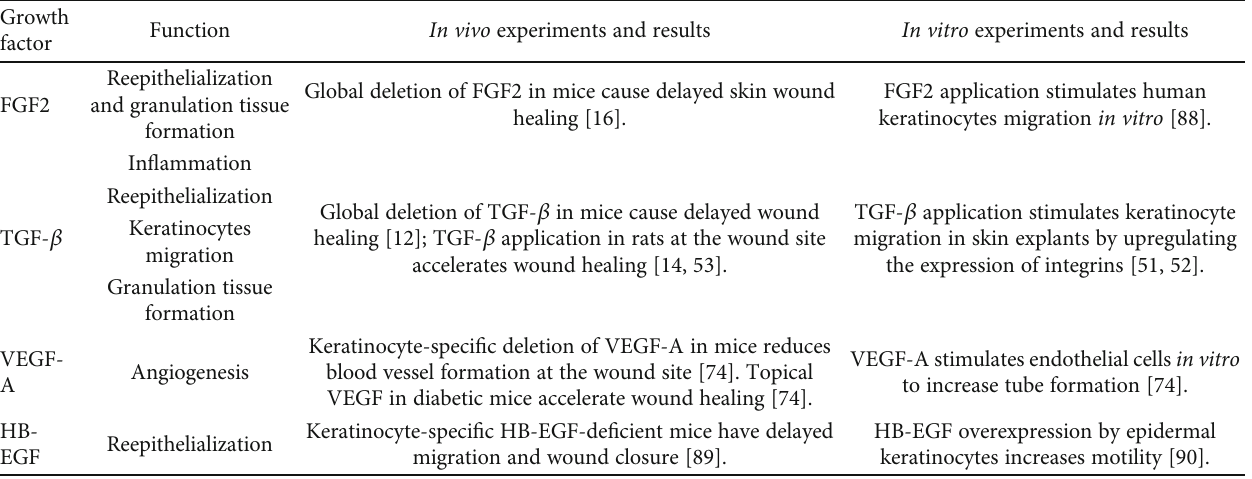
Table 1: Examples of growth factors produced by keratinocytes that promote wound